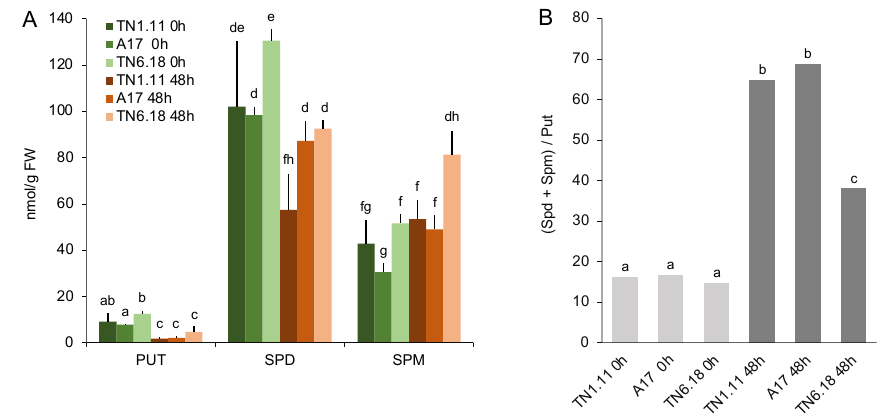
Figure 2. Levels of free Put (putrescine), Spd (spermidine), and Spm (spermine) ( A ) and ratio polyamines:diamine (Spd + Spm/Put) ( B ) in leaves of TN1.11, A17, and TN6.18 genotypes following 0 and 48 h salt stress (200 mM NaCl). Different tetters indicate significantly different values according to a Student–Newman–Keuls test ( P <